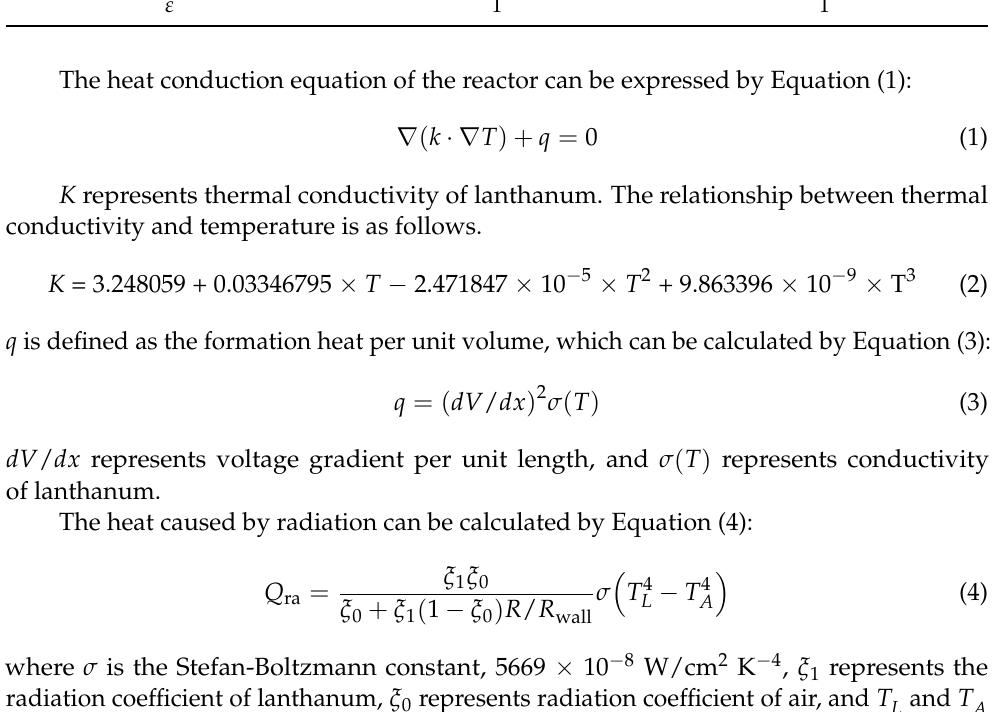
Table 2. The numerical values of the parameters. Parameter Value Unit µ 1 H/m σ ( T ) 0.2 MS/cm ξ 1 0.64 1 ξ 0 0.5 1 ε 1